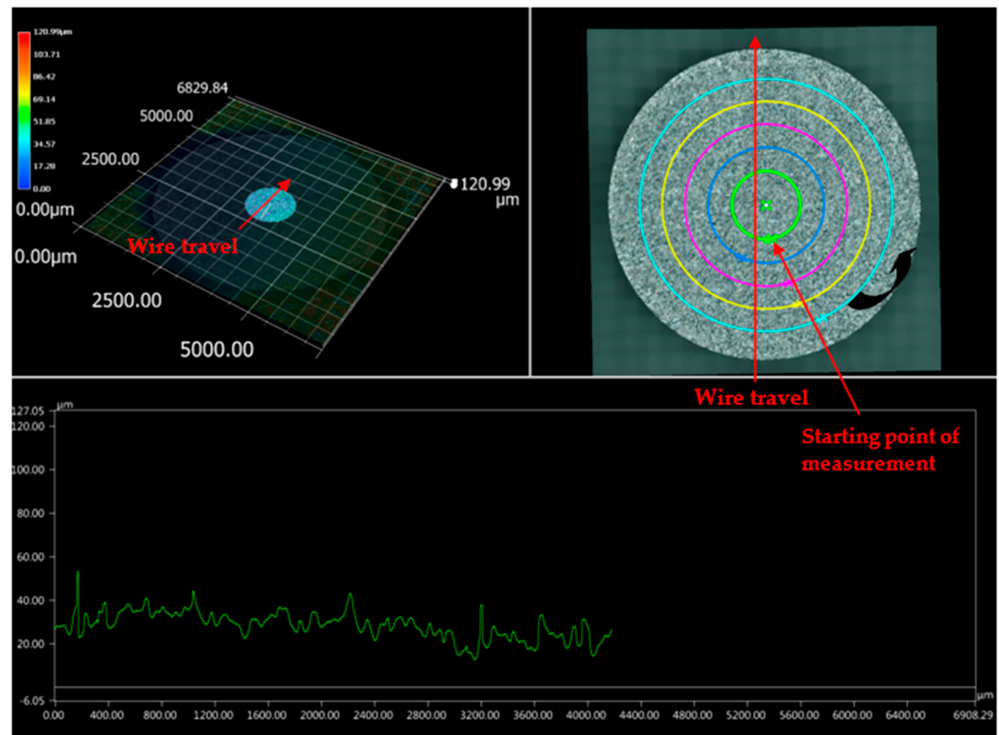
Figure 6. Surface analysis of machined sample at innermost